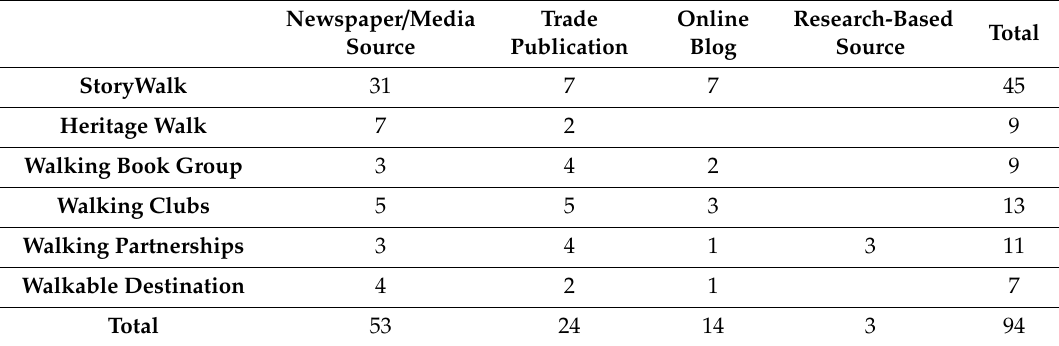
Table 2. Articles in online corpus, by publication type. See below for a description of items in